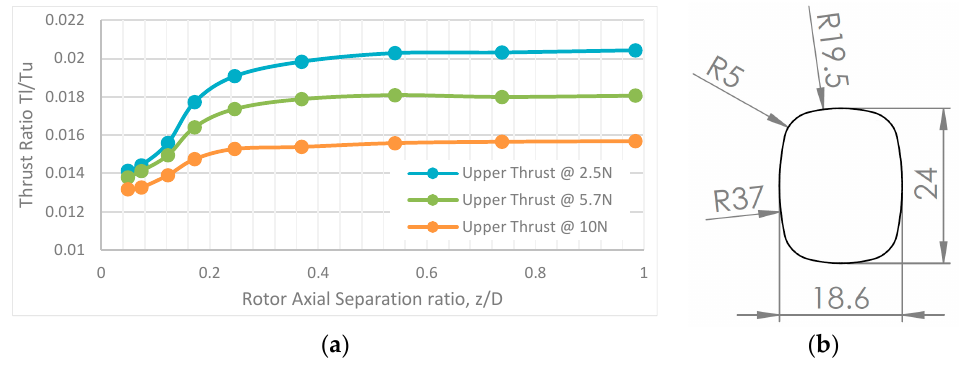
Figure 10. Test rig arm profile drag. ( a ) Arm profile drag as a function of rotor axial separation z ; ( b ) test rig arm profile geometry (in mm).